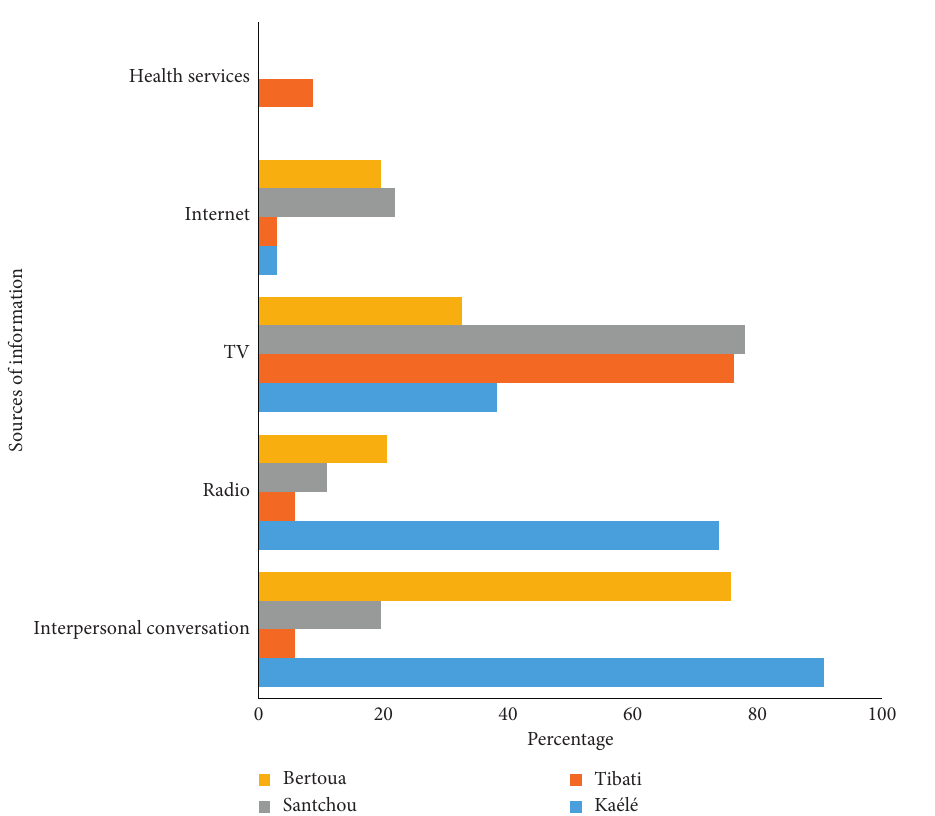
Figure 2: Sources of information about malaria in Ka´el´e, Tibati, Santchou, and Bertoua. Table 3: Population knowledge and attitude concerning malaria prevention and usage of LLINs in Ka´el´e, Tibati, Santchou, and Bertoua.